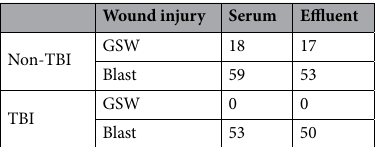
Table 2. Number of patients segregated according to the type of wound injury (Blast vs. Gunshot wound